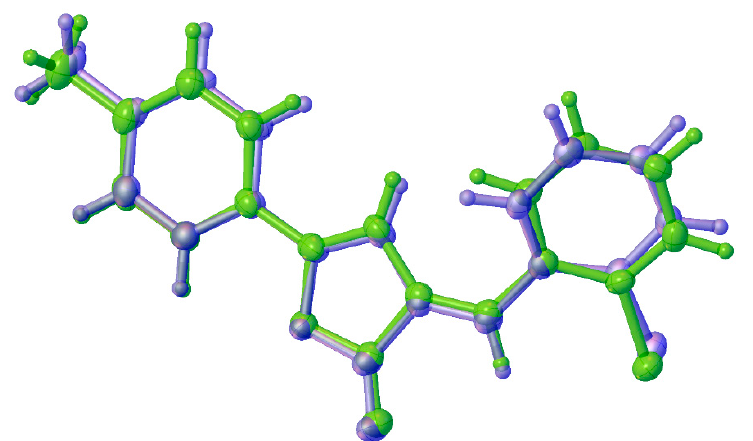
Figure 3. The overlay diagram of the two crystallographically independent forms of 1 in the asym- metric unit. Displacement ellipsoids are drawn at the 50% probability level.